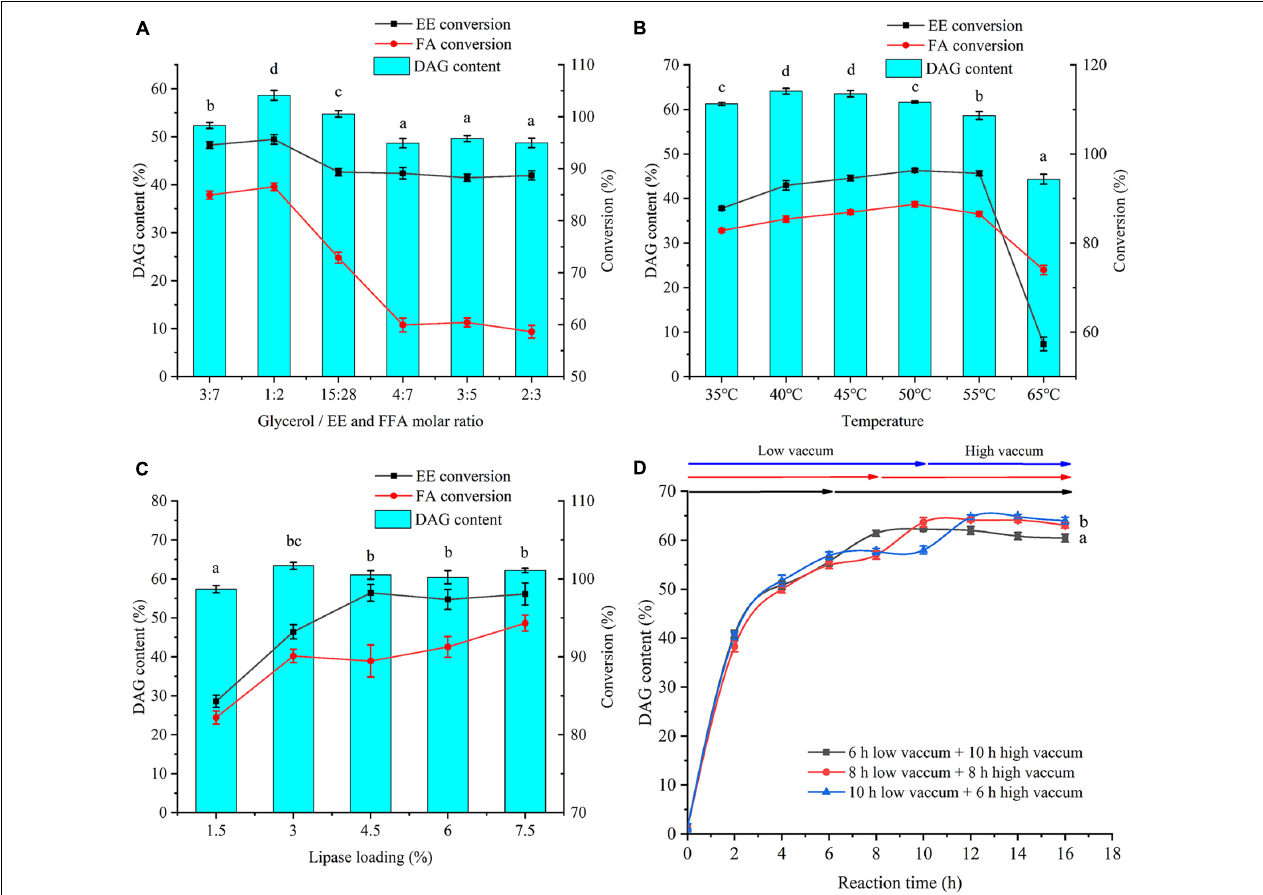
FIGURE 3 | Effects of substrate molar ratio (glycerol/FFA and EE) (A) , temperature (B) , ANL-MARE loading (C) , and reaction time (D) on DAG content, EE, and FFA conversion. The different letters indicate significant differences at P <